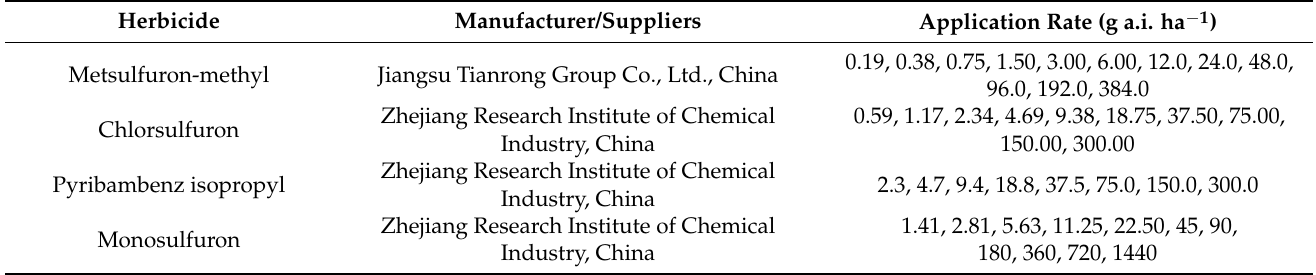
Table 1. Herbicides used in whole plant dose response experiment.